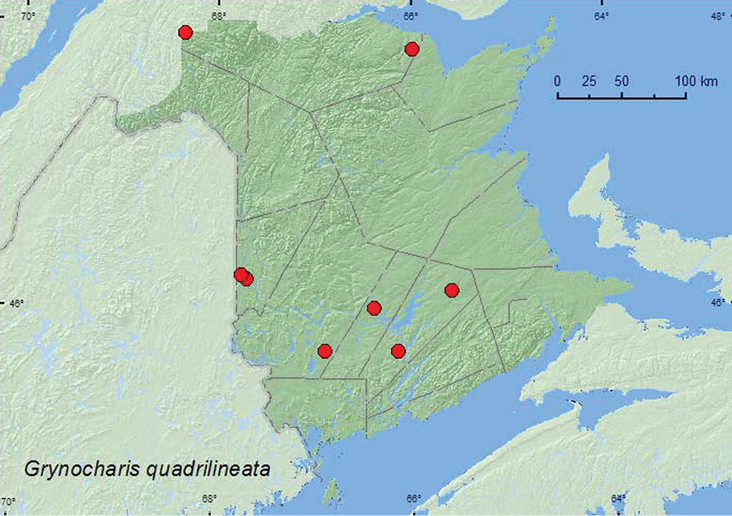
Collection localities in New Brunswick, Canada of Grynocharis quadrilineata